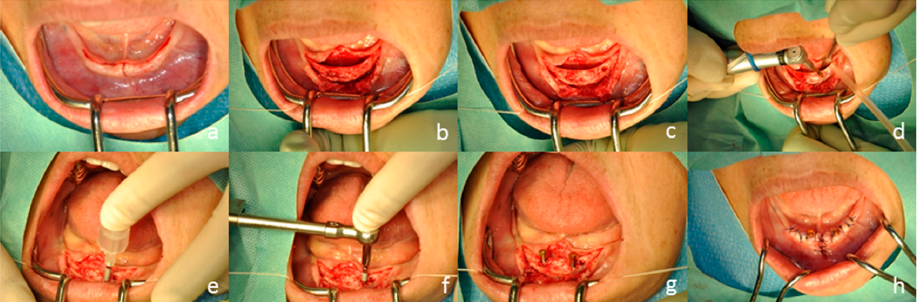
Figure 4. The plaster model of mandible fabricating by a three-dimensional printer on the CT data. Front ( Left ) and rear ( Right ) views.